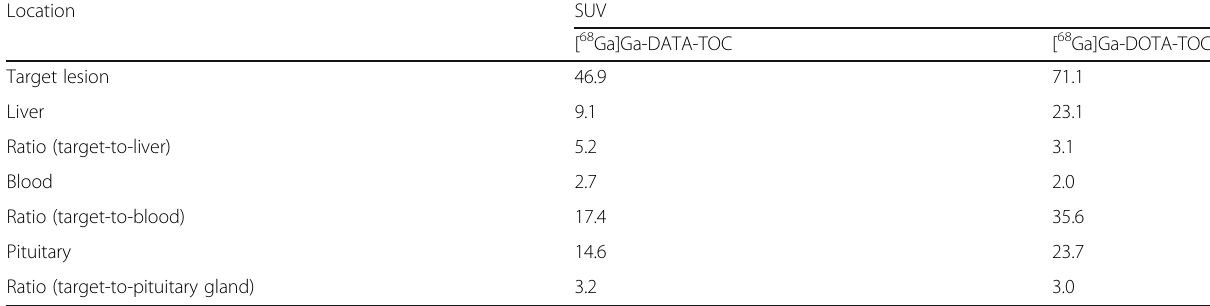
Table 1 Comparison of SUVs between [ 68 Ga]Ga-DATA-TOC and [ 68 Ga]Ga-DOTA-TOC in a 46-year-old male patient with a well- differentiated NET in the body and tail of the pancreas